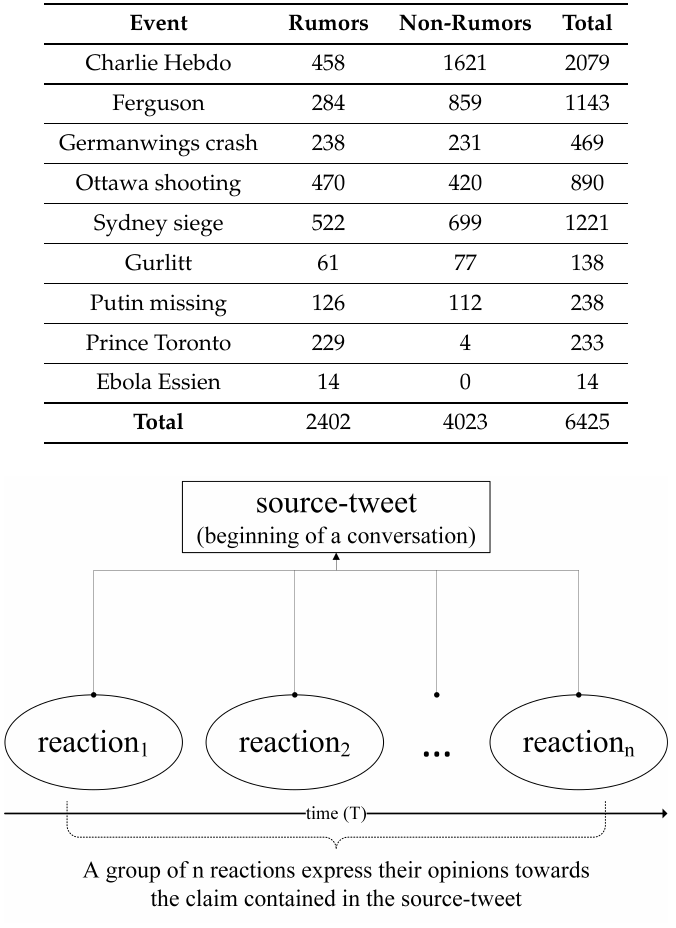
Figure 3. Structure of a Twitter conversation sample.